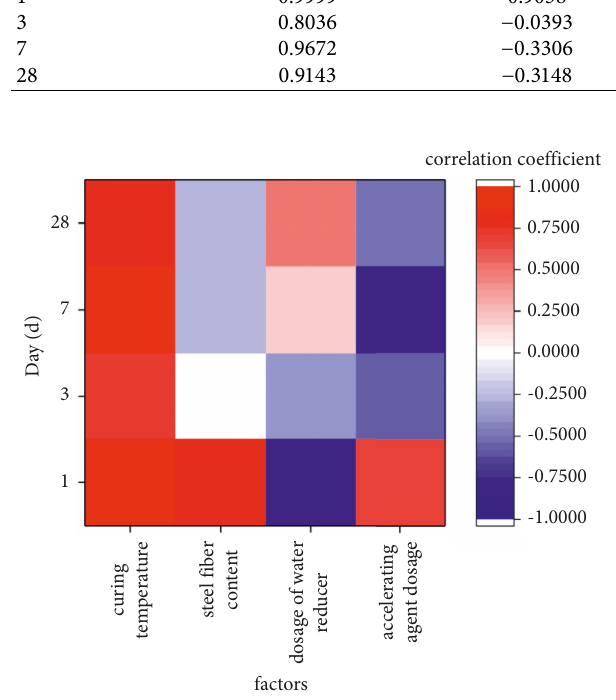
Figure 3: The compressive strength of concrete specimens is correlated with various